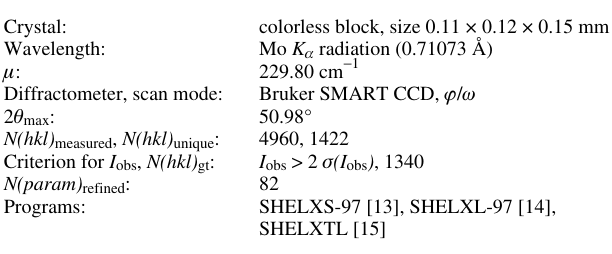
Table 1. Data collection and handling.